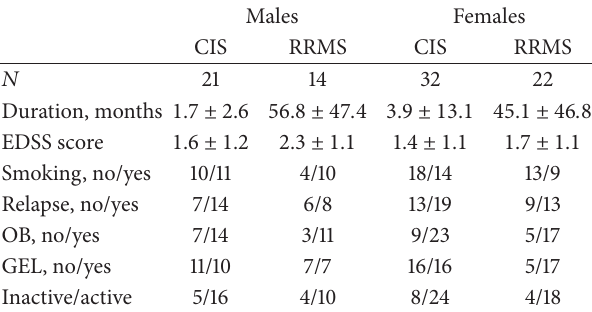
Table 1: Clinical data of male and female therapy-na¨ıve patients with clinically isolated syndrome suggestive of MS (CIS) or with relapsing-remitting MS